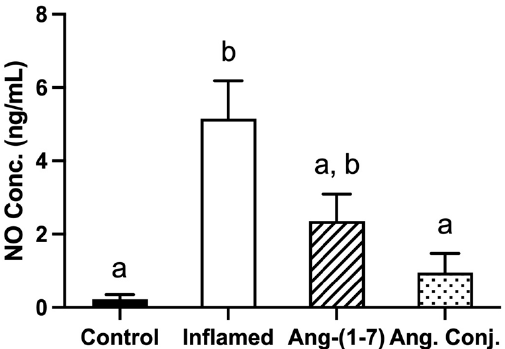
Figure 3. Effect of adjuvant-induced arthritis and Ang-(1-7) or Ang. Conj. treatment on serum NO concentrations at the end of the experiment. The number of animals in control and inflamed groups were six, and in Ang-(1-7) and Ang. Conj.-treated groups were five. The values are reported as mean ± SEM, and statistical analysis was done using one-way ANOVA with the Tukey multiple compar- ison post-hoc test. Groups labeled with different letters have significant differences between them ( p < 0.05).